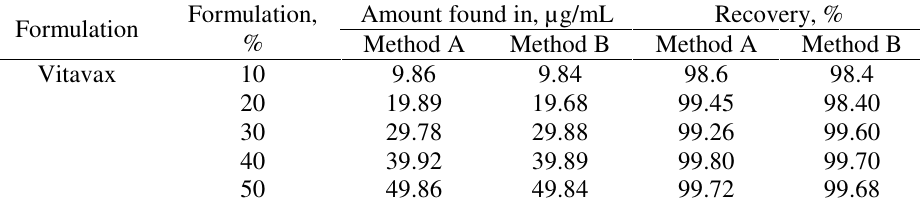
Table 2. Determination of carboxin in formulations